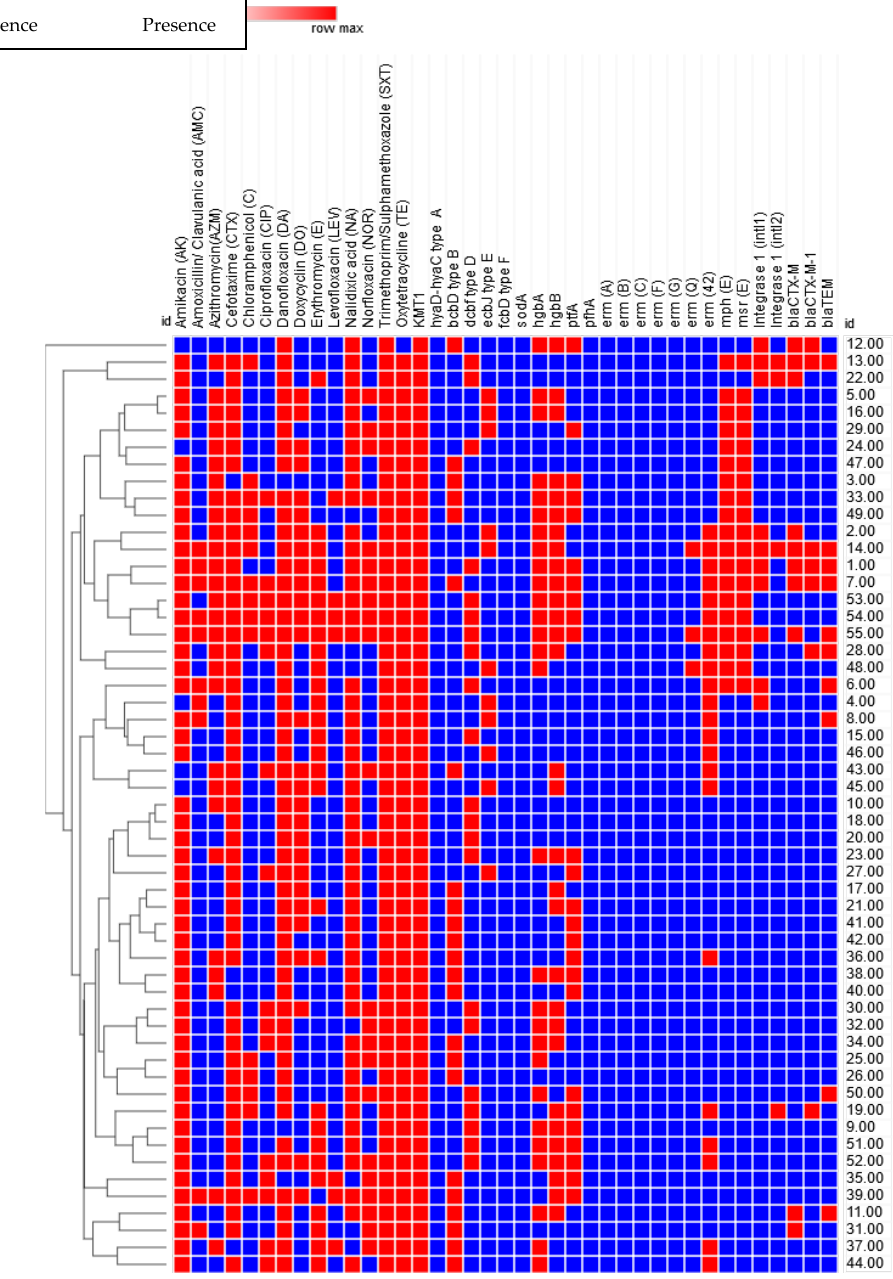
Figure 6. A heatmap and hierarchical clustering of the P. multocida isolates to 7 clusters based on their phenotypic (antimicrobial resistance), genotypic (antimicrobial resistance genes), and virulence genes expressing differences between isolates. Red represents presence and blue represents absence of phenotypic resistance, resistance genes, and virulence genes. Hierarchical clustering was performed using Wald’s method and a binary distance matrix. The numbers on the right of the heatmap refer to the isolate numbers from 1 to 55.